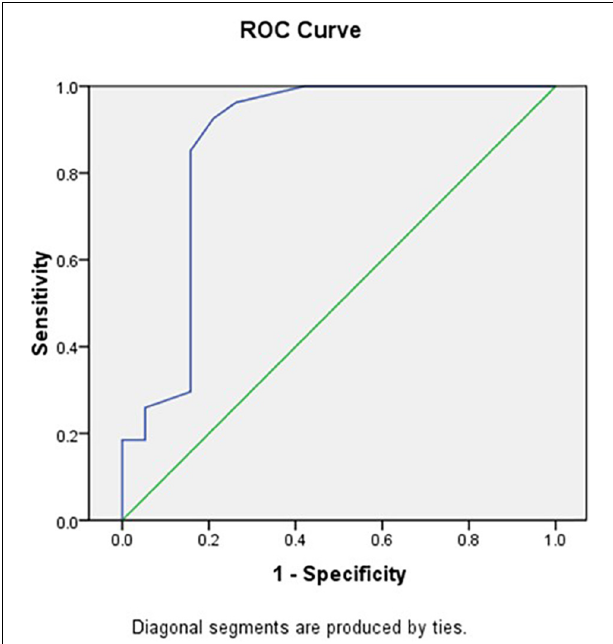
FIGURE 1 | ROC curve analysis of total BIPAQ